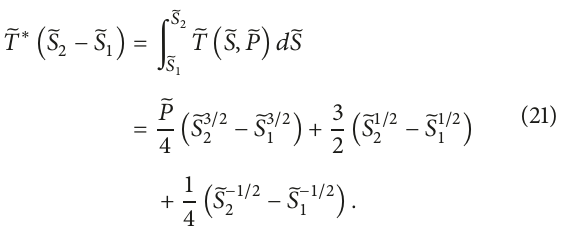
̃𝑃 ≤ 1.0 . The dashed black line (̃𝑇 = 0.870155, ̃𝑃 =